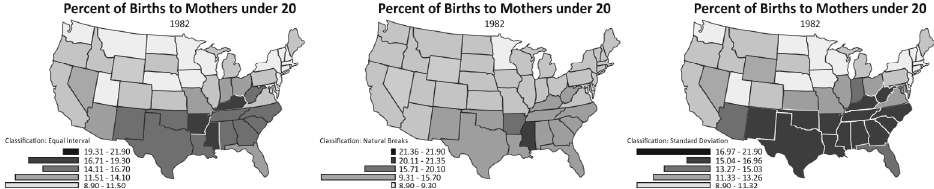
Fig. 6. Example of a non-temporal animation (selected frames) presenting how the image of a phenomenon affects the number of choropleth map